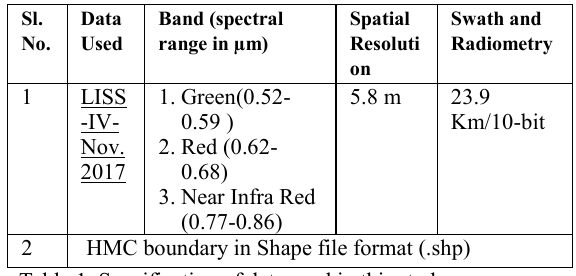
Table 1. Specification of data used in this